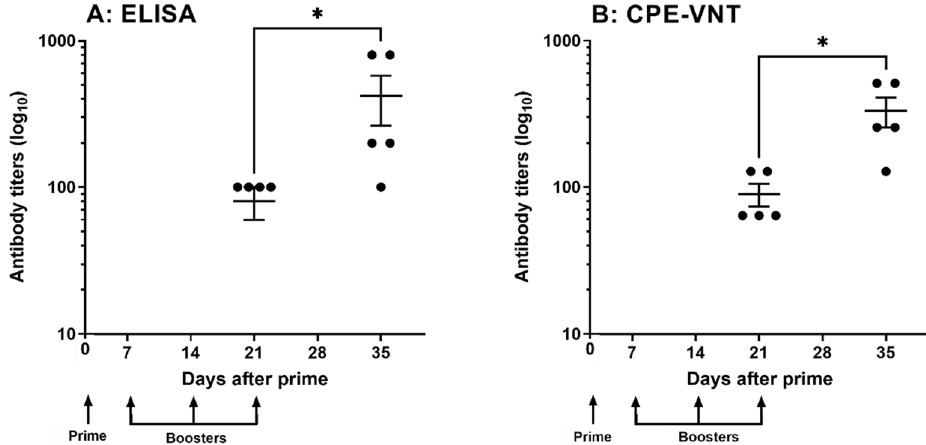
Figure 2. Purified and inactivated SARS-CoV-2 virus immunogenicity in mice. ( A ) ELISA plates were coated with 100 µL of purified and inactivated SARS-CoV-2 (1 × 10E + 03 virus/mL), incubated with increasing dilutions of nonimmune or experimental sera obtained from BALB/c mice, and incubated with anti-mouse HRPO-conjugated IgG. The reaction was performed by adding TMB substrate, and the absorbance was detected at λ 450 nm using a spectrophotometer. The titre was established as the highest serum dilution at which the measured absorbance was twice as high as that determined for nonimmunized mouse serum (control group). ( B ) Sera from mice immunized with purified and inactivated SARS-CoV-2 antigen were also tested using the CPE-VNT. The neutralization titre was defined as the inverse of the highest dilution of serum that blocks viral replication. Statistical analyses were performed using Student’s t-test followed by the Mann–Whitney test (*p ≤